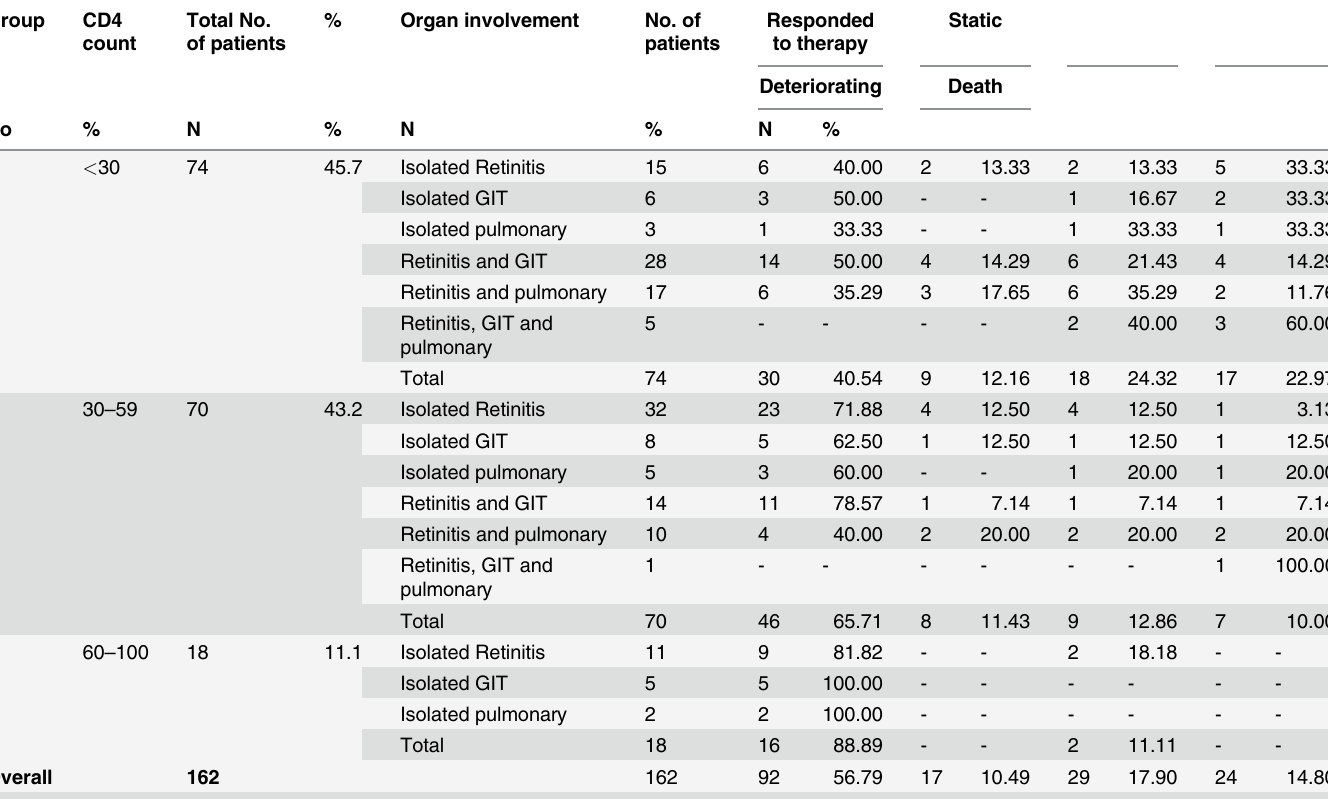
Table 2. Distribution and Outcome of CMV End Organ Diseases across the strata of CD4 count among the participating HIV/AIDS patients having CMV EODs (N = 162). Group CD4 Total No. % count of patients